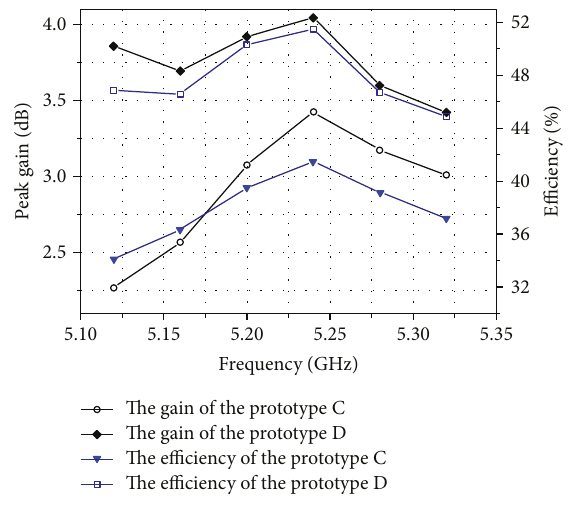
Figure 10: The measured peak gain and e ffi ciency of prototype C and prototype